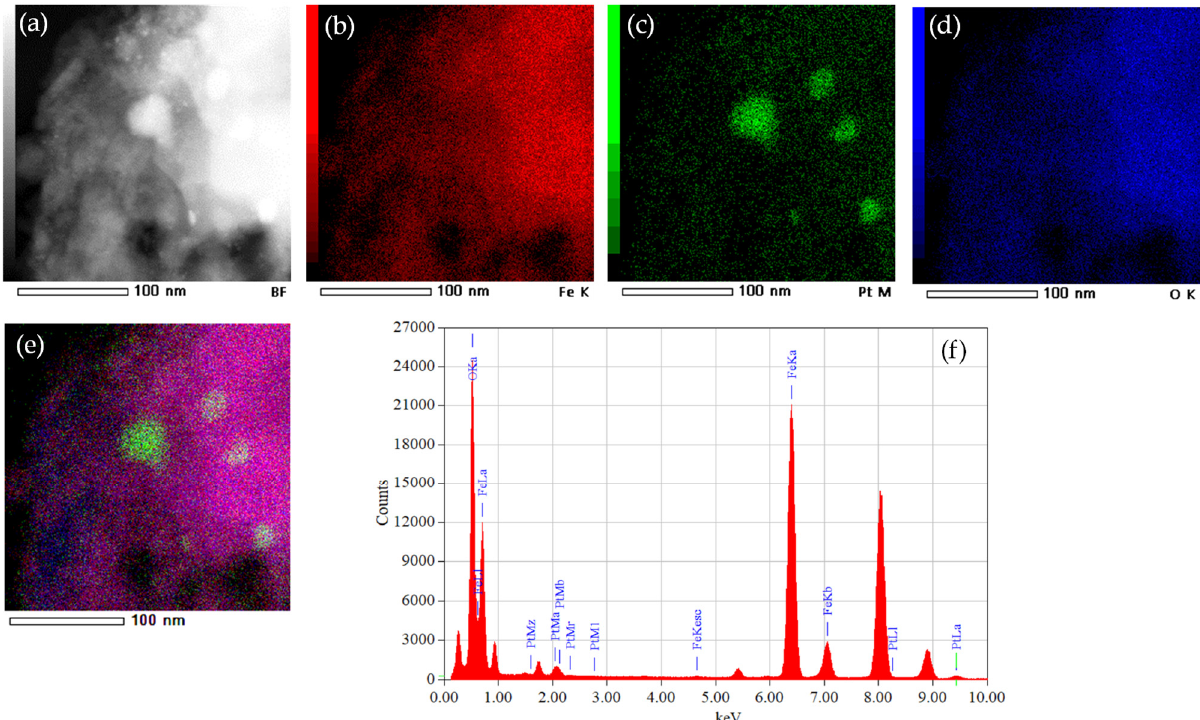
Figure 7. STEM image of sample FE-1 ( a ) and corresponding EDXS elemental mapping images of Fe K edge ( b ), Pt M edge ( c ), O K edge ( d ) and overlay of Fe K, Pt M and O K edges ( e ). EDXS spectrum of sample FE-1 ( f ).